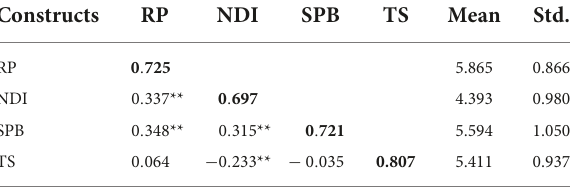
TABLE 4 Results of discriminant validity.